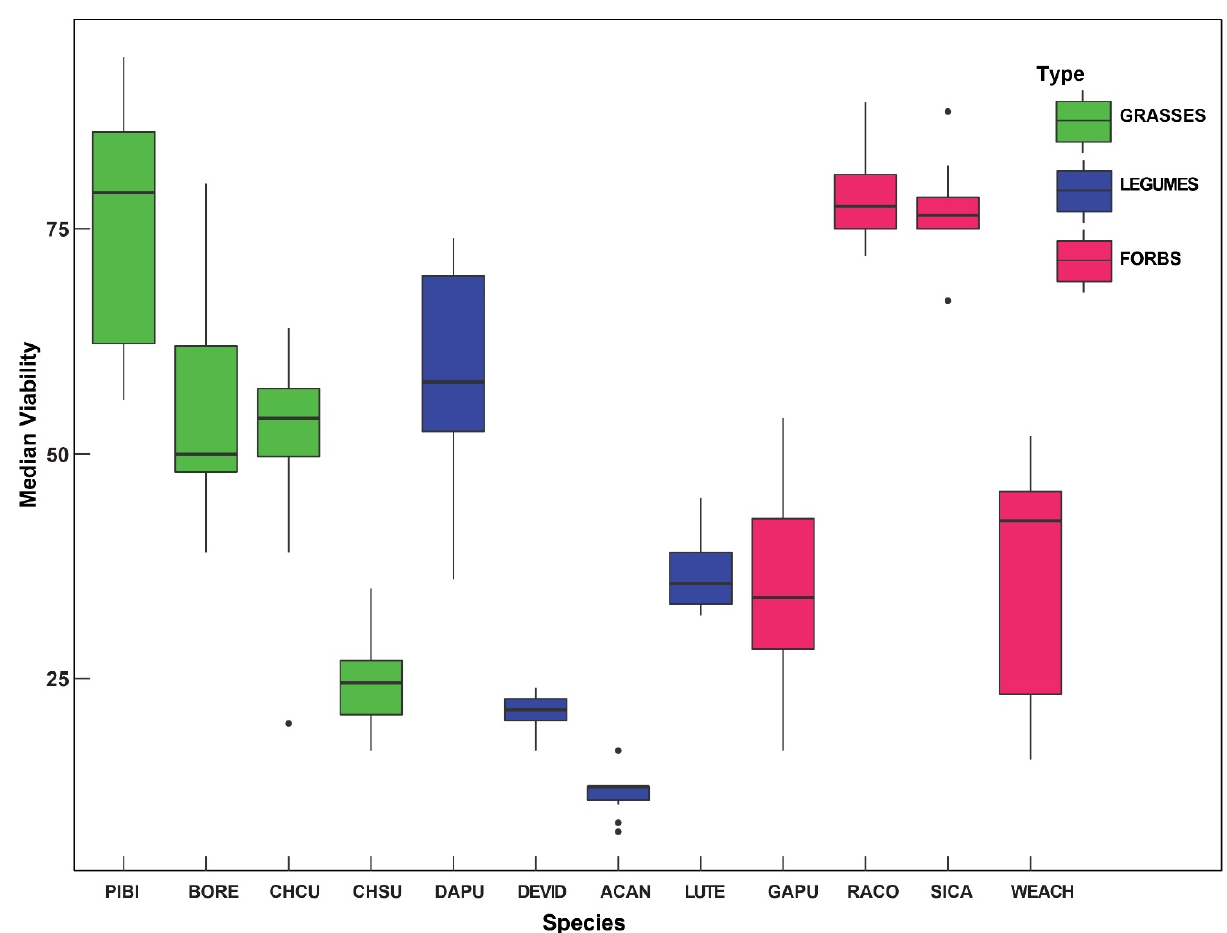
Figure 1. Box plot representing the viability percentage of each species with significant differences denoted between all the species. Species are subcategorized by plant type, P. bicolor (PIBI) , B. repens (BORE), C. cucullata (CHUC) , C. subdolistachya (CHSU), D. purpurea (DAPU), D. virgatus (DEVID), A. angustissima (ACAN), L. texensis (LUTE), G. puchella (GAPU), R. columnifera (RACO), S. calva (SICA), and W. acapulcensis (WEACH).